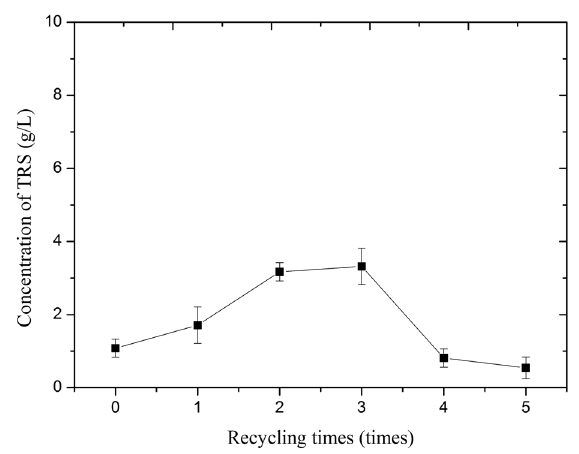
Figure 6: EDS spectra of hydrolyzed cellulose after three waste liquid